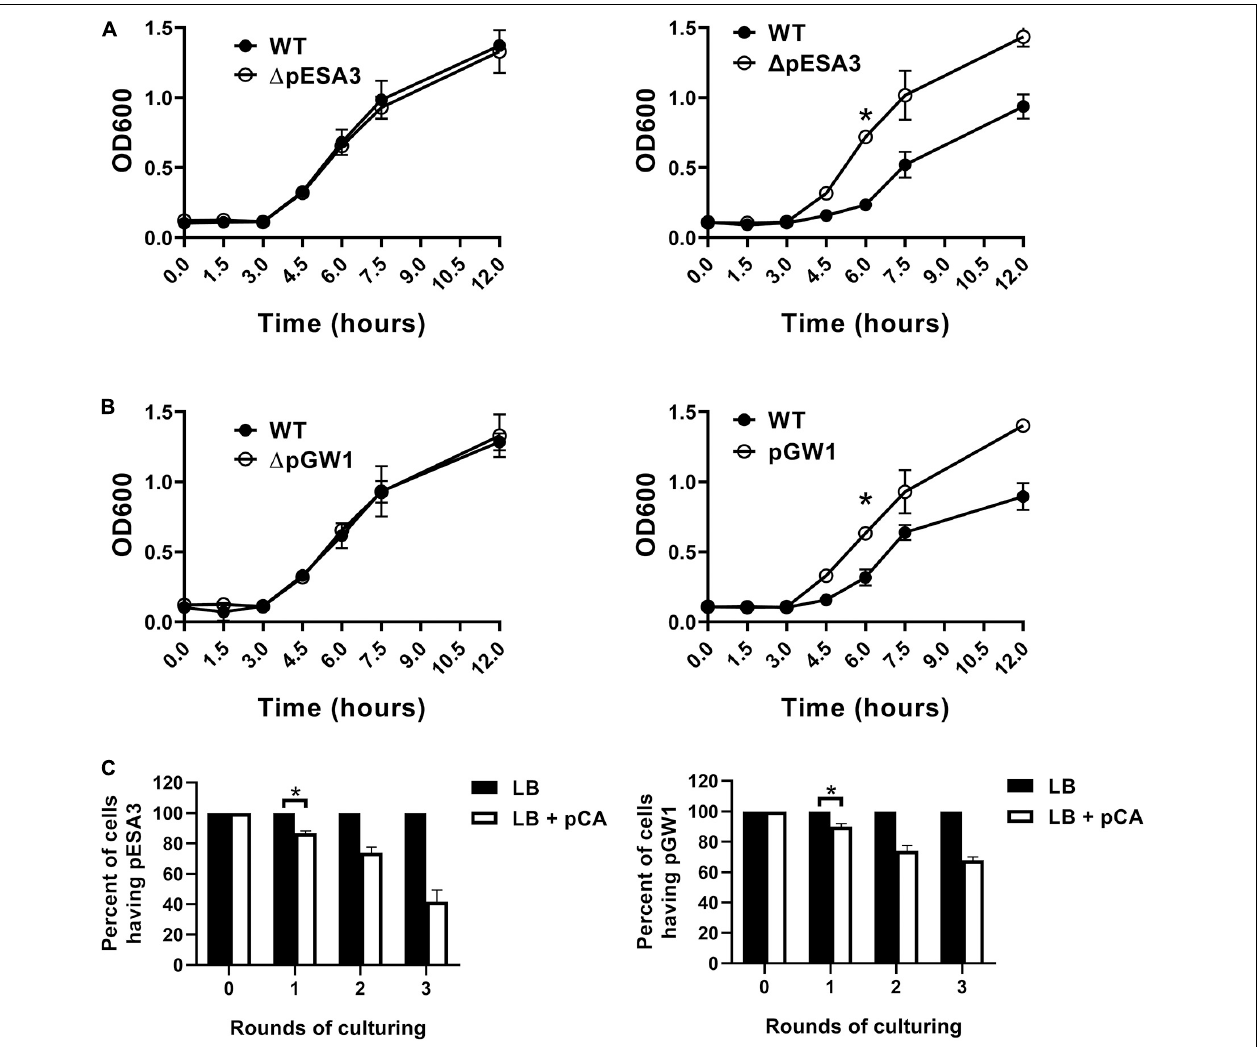
FIGURE 4 | Plasmid-curing ability of p -coumaric acid in Cronobacter sakazakii . (A) Growth of wild-type C. sakazakii BAA-894 and its (cid:49) pESA3 derivative in LB (left) and in LB containing 250 mg/L p -coumaric acid (right). (B) Growth of wild-type C. sakazakii GZcsf-1 and its (cid:49) pGW1 derivative in LB (left) and in LB containing 250 mg/L p -coumaric acid (right). (C) Percent of plasmid-cured isolates of each culture round in LB or in LB containing 250 mg/L p -coumaric acid (pCA). Left: initial strain was wild-type C. sakazakii BAA-894, right: initial strain was wild-type C. sakazakii GZcsf-1. At the beginning of the experiment, a total of 10 5 CFU of wild-type bacteria was added to 10 mL of LB or LB containing pCA. The cultures were shaken overnight at 37 ◦ C and then inoculated into 10 mL of fresh sterile LB medium or LB containing pCA at a 1:100 dilution the next day, respectively. After each round of culturing, bacterial samples were serially diluted and plated on agar to obtain signal colonies. Finally, 100 single colonies were selected, and their genotypes were determined by PCR using plasmid-specific primers. All data represent the average and standard deviation of three biological repeats (Student’s t -test; * P <